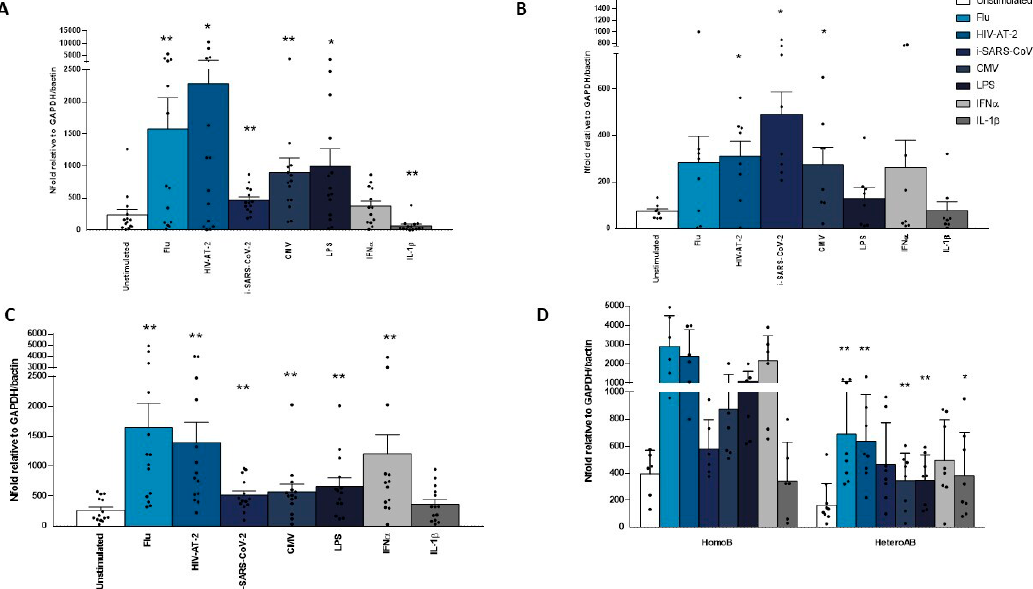
Figure 2. ERAP1, ERAP2 / Iso1 and ERAP2 / Iso3 mrna expression is increased following microbial stimulation. pbmcs isolated from 8 heteroab and 6 homob individuals were in vitro stimulated with microbial antigens (flu, CMV) inactivated viruses (i-SARS-CoV-2, HIV-AT-2) bacterial by-products (LPS) or inflammatory stimuli (IFN α , IL-1 β ) for ten h. mRNA expression for ERAP2 / Iso3 ( A ), ERAP2 / Iso1 ( B ) and ERAP1 ( C ) were assessed by RT-Real-Time PCR. Results are shown as the media of the relative expression units to the glyceraldehyde-3-phosphate dehydrogenase (GAPDH) and β -actin reference genes calculated by the 2 − ∆∆ Ct equation. ( D ) The microbial-dependent genetic control of ERAP2 / Iso3 expression is underlined by the observation that its abundances are nearly doubled in HapB homozygotes compared to heterozygotes. Results are expressed as mean ± ES. * = p < 0.05; ** = p <